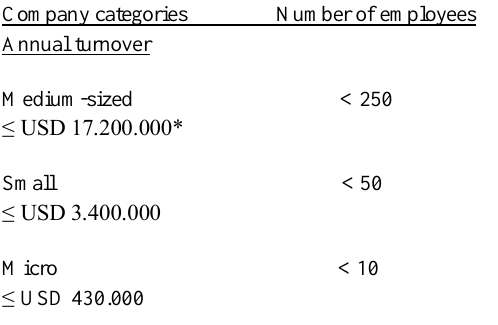
Table 2: Distribution of firms in Turkey (2009) Company